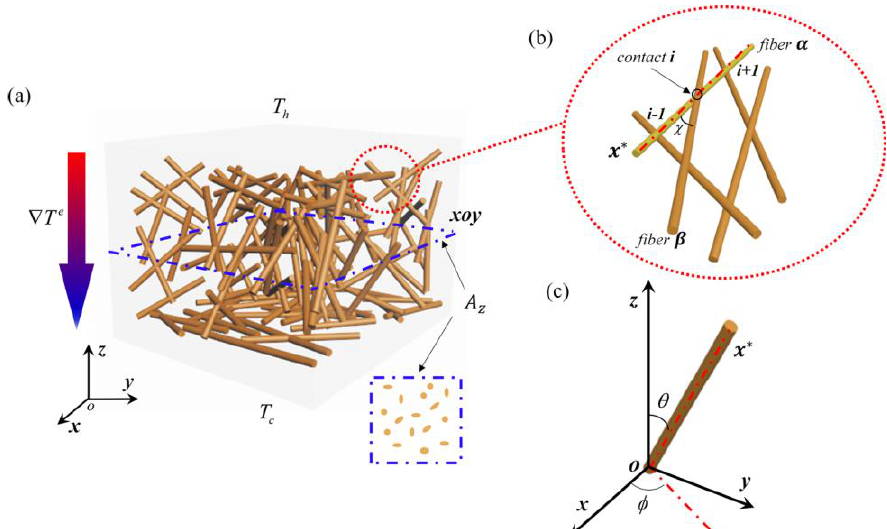
Figure 18. Schematic of nanofiber networks and coordinate systems for modeling: ( a ) 3D nanofiber networks; ( b ) contacts in nanofiber networks; ( c ) coordinates for analysis. Reproduced under